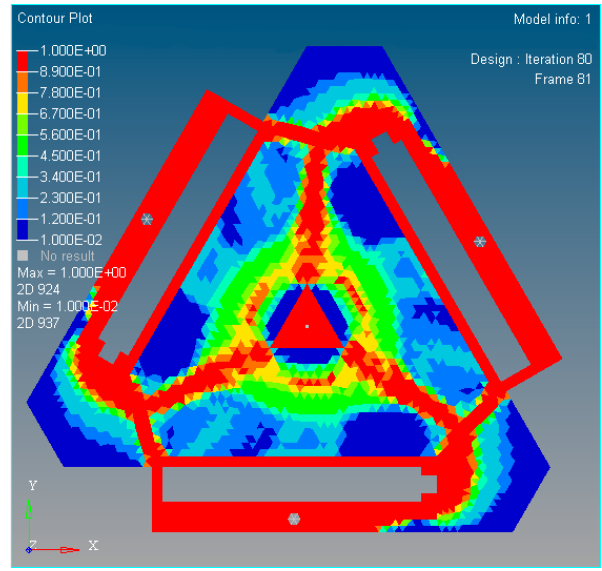
Figure 14. The multi-objective function topological optimization results of the new mechanism.